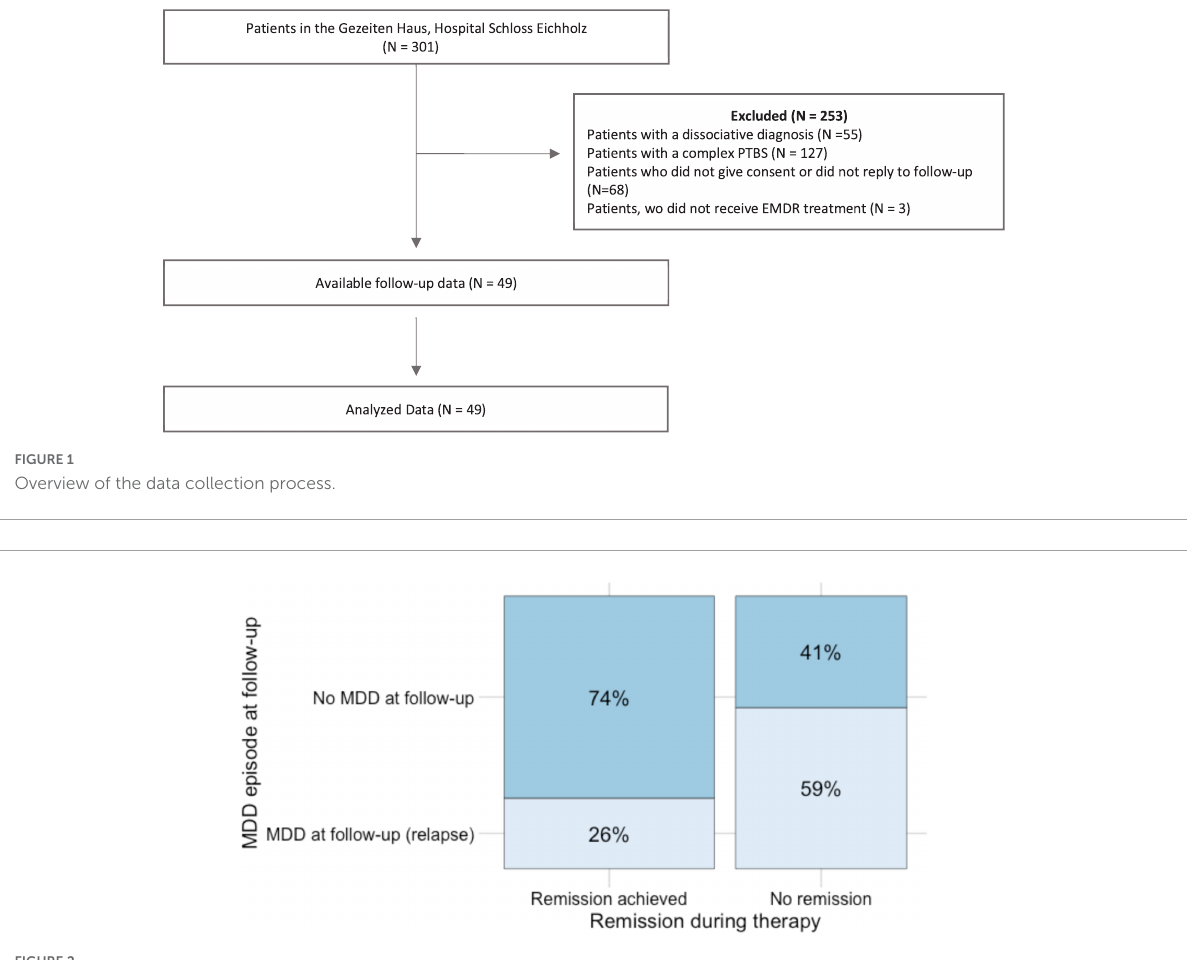
FIGURE2 Distribution of relapse and remission in the study cohort.